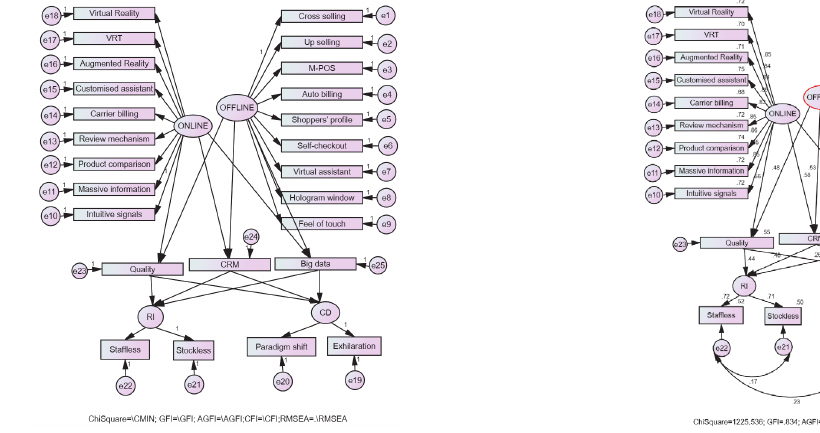
Fig. 3. Structural model for Usage of AI technol- ogies in Retail user